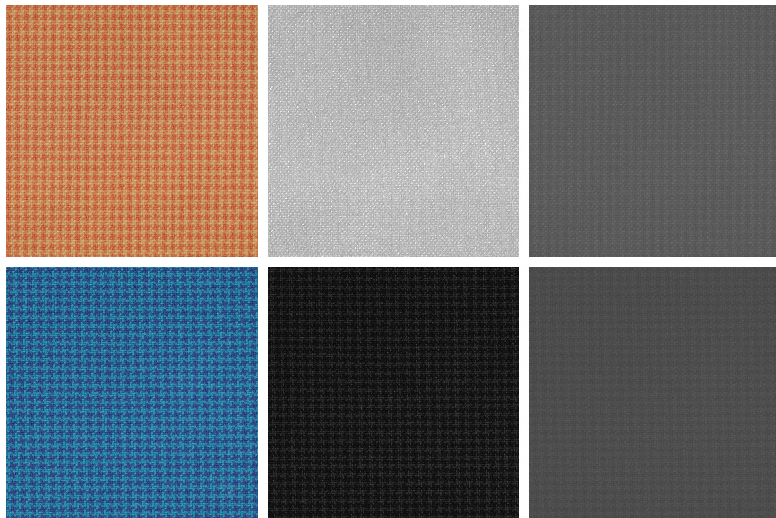
Figure 17. Texture image sample: textile_14_orange (top) and textile_14_blue (bottom). From the left to the right : sRGB rendering, 93th channel (centered at 699 nm) and 1st PCA channel. The images